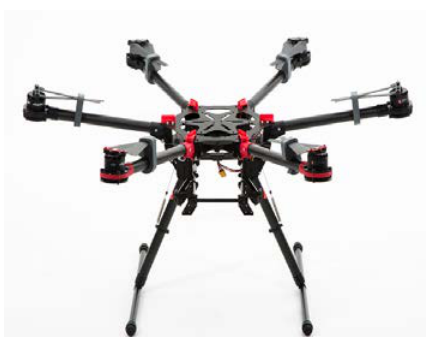
Figure 1. Spread Wings